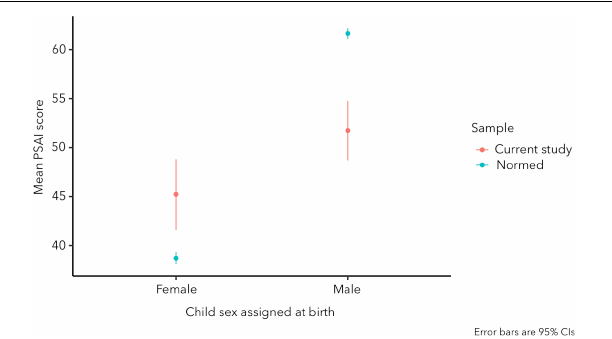
FIGURE 1 | Pre-School Activities Inventory (PSAI) scores among children in the current study and in the normed sample as a function of sex assigned at birth, adjusted for child